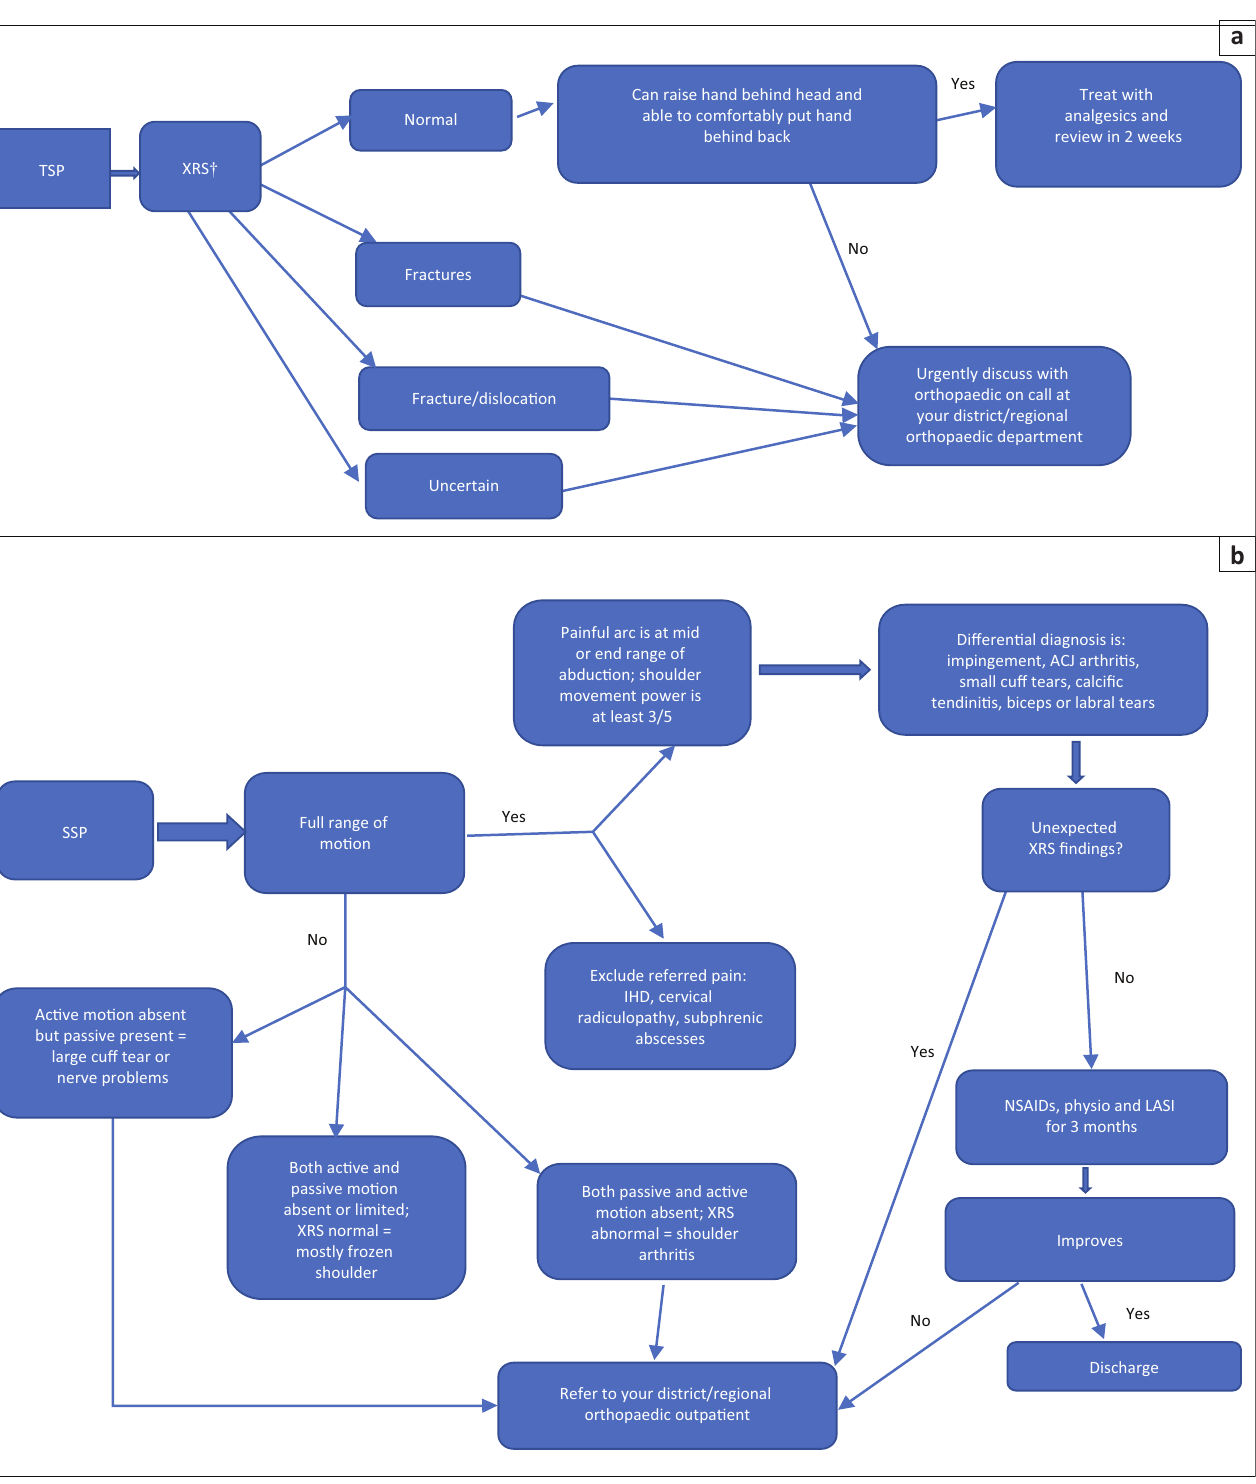
FIGURE 1: (a) Assessment and management of traumatic shoulder pain. (b) Assessment and management of spontaneous shoulder pain with no red